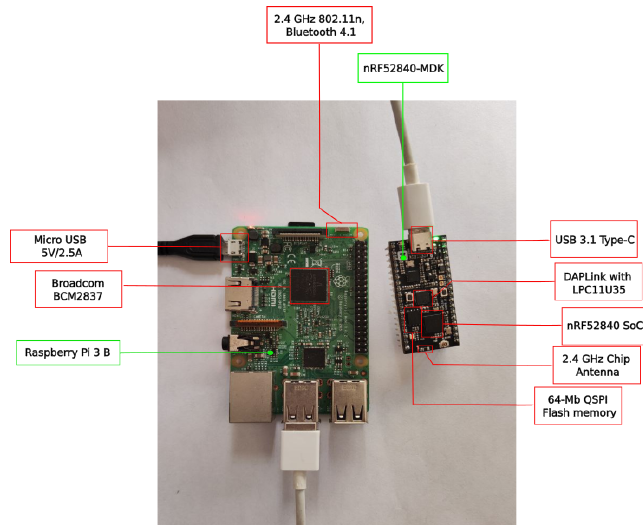
Figure 6. Components of one of the testbed IoT nodes.